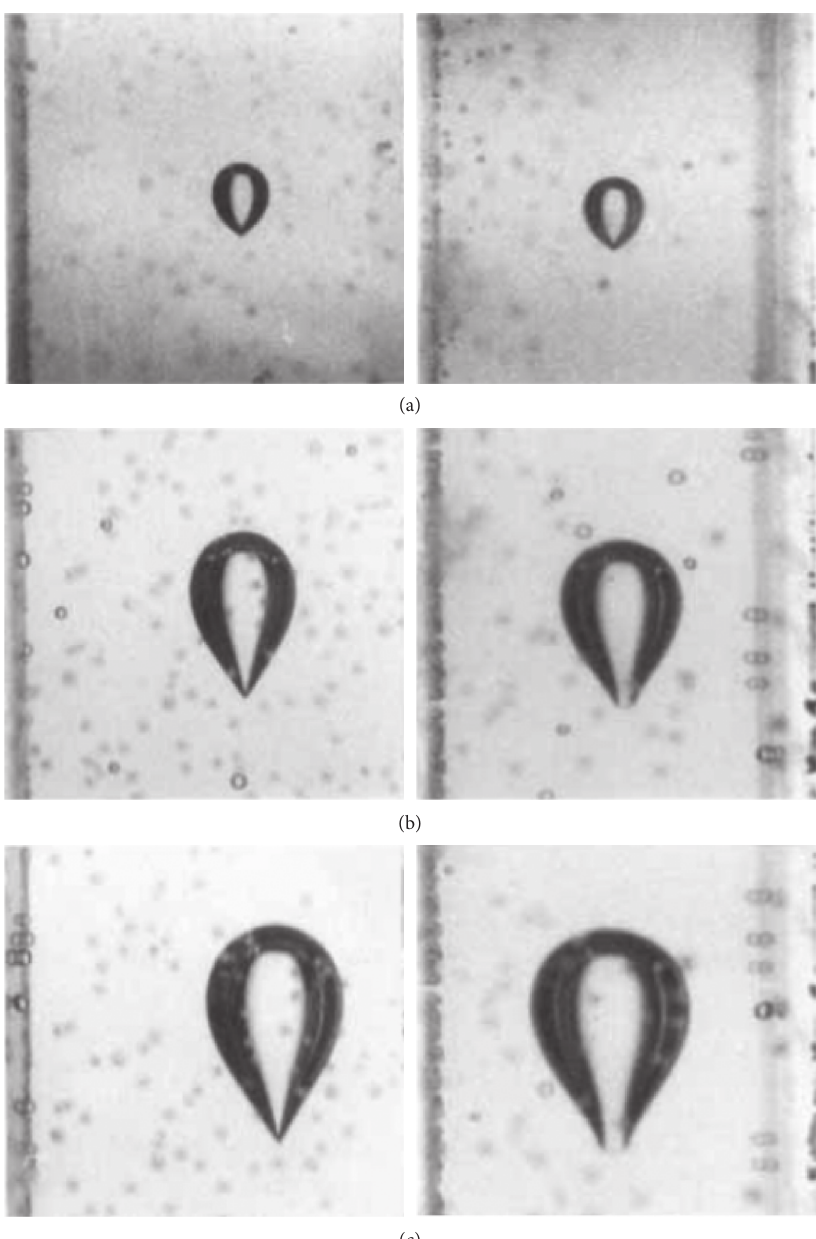
Figure 4: Cusped bubbles rising in a 1.5% polyox solution (a) below the critical volume and (b), (c) above the critical volume